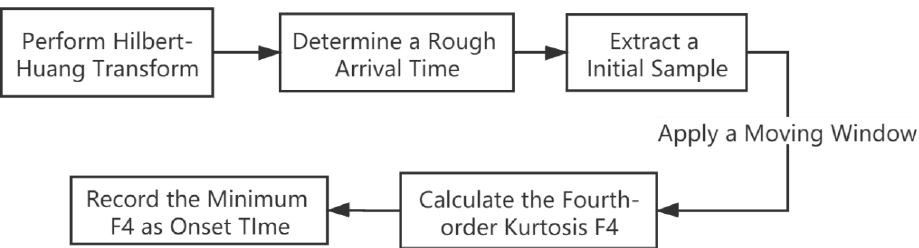
Figure 2. Flowchart of carrying out Hilbert-Huang Transform (HHT)-kurtosis method.